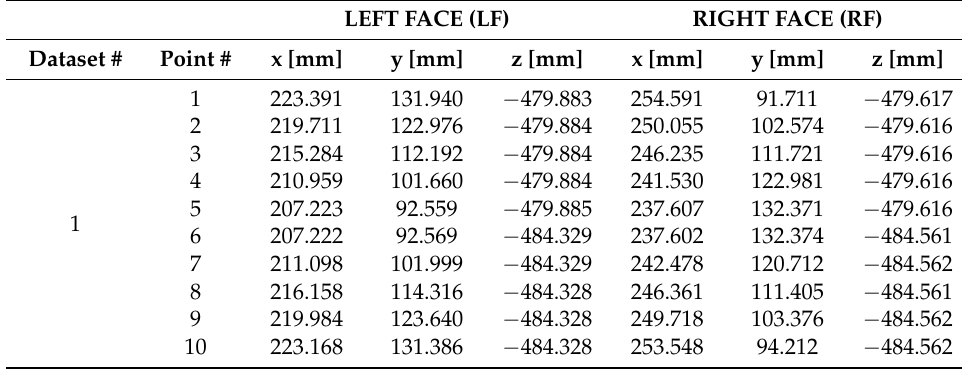
Table A2. Angle block